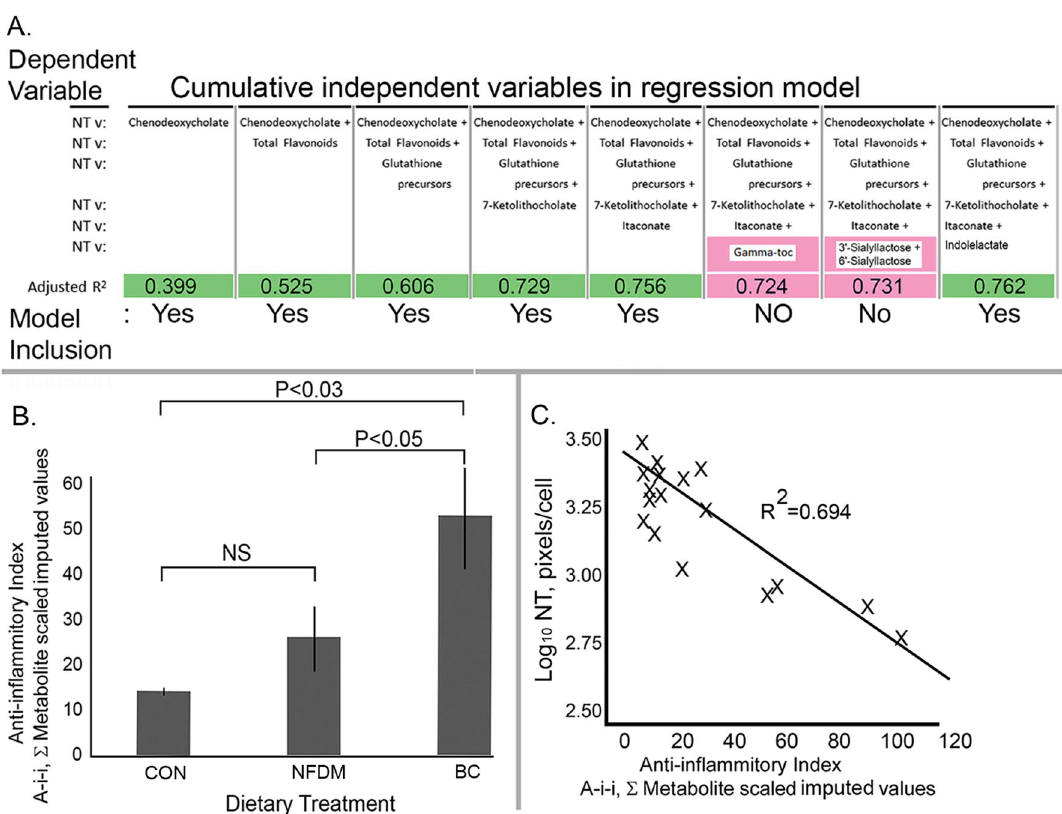
Fig. 4 Correlation between anti-inflammatory index (A-i-i) and epithelial cell protein nitration (NT). Multiple regression was used to assess the relationship between the level of NT content (Log10, pixels/cell) present in intestinal epithelial cells and the independent metabolite variables. Inclusion of a metabolite (class) to the model was valid if the resulting adjusted R 2 was increased over that of the prior iterative assessments (Panel A ). The effects of dietary treatment on the A-i-i (the sum of the Scaled Imputed Values of the individual metabolites retained in the model, Panel B ). Linear regression of the NT pixel content on the A-i-i suggested a significant negative correlation where the greater the A-i-i- the lower the nitration stress (Panel C